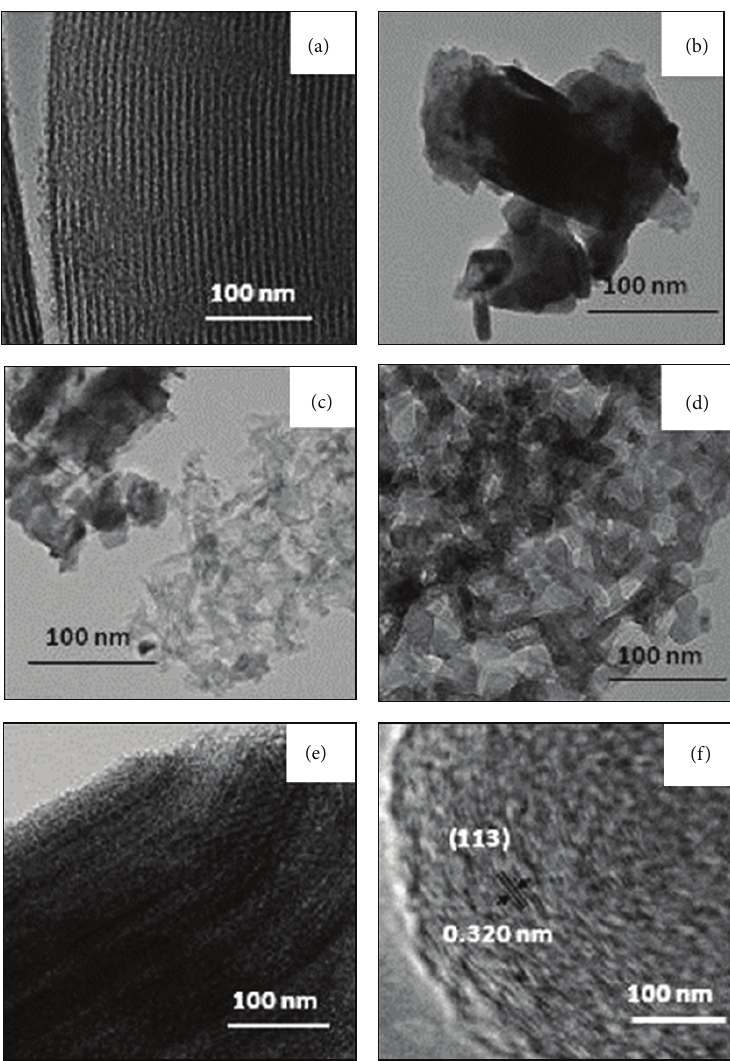
Figure 3: TEM image of (a) SBA-15, (b) Bi 2 WO 6 , (c) S 1 , (d) S 3 , and (e) S 2 and (f) the HRTEM image of S 2